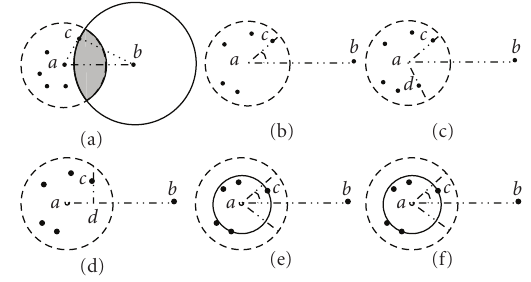
Figure 7: Greedy routing algorithms.